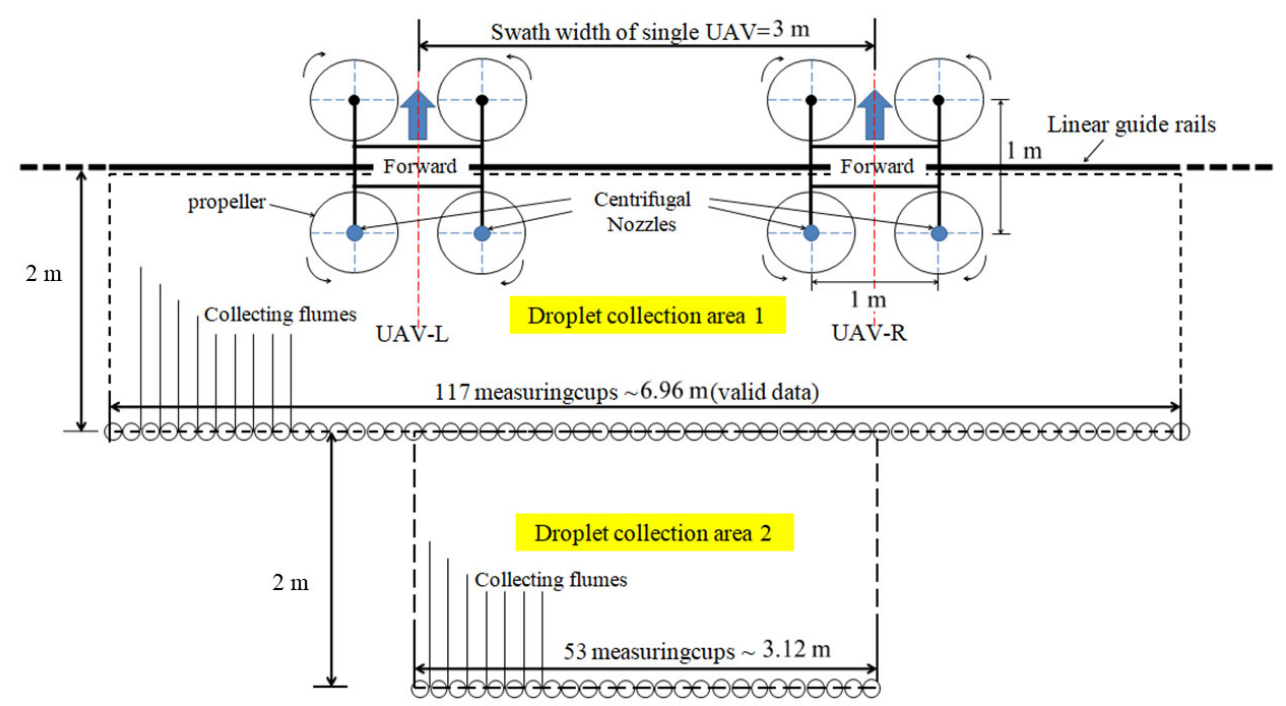
Figure 8. Top view of indoor test platform.